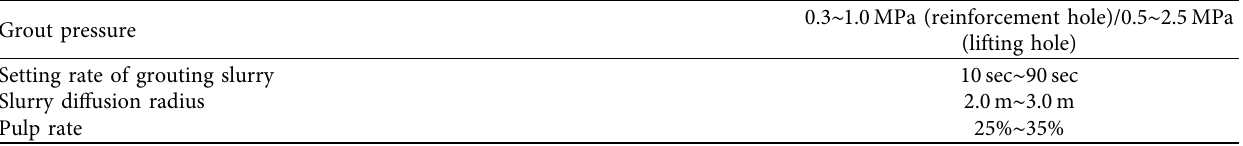
Table 3: Parameters of